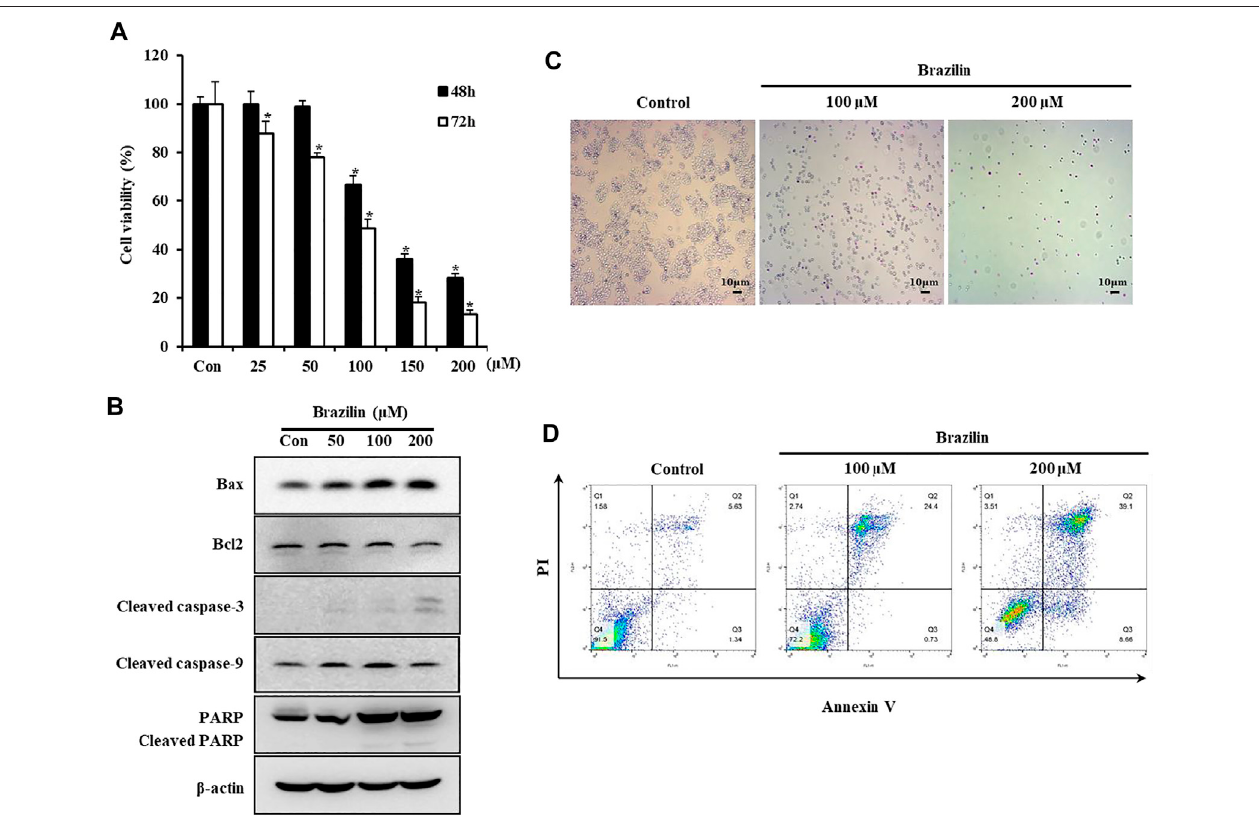
FIGURE 1 | The effects of brazilin on cell viability in colorectal cancer SW480 cells. (A) SW480 cells were treated with different dosages of brazilin for 48 h or 72 h. CellviabilitiesweremeasuredbyMTTassay.Dataareshownasmean±SDofthreeindependentexperiments.The p -valuesdeterminedusingStudent ’ st-testwere* p < 0.05 compared with controls. (B) SW480 cells were treated with different concentrations of brazilin for 72 h. Whole cell lysates were prepared, and apoptosis was assessed using Western blot analysis with anti-Bax, anti-Bcl2, anti-cleaved caspase-3, anti-cleaved caspase-9, and anti-PARP/cleaved PARP antibodies. After treatment with brazilin for 72 h, cells were analyzed using APOPercentage Apoptosis Assay kit (C) and fl ow cytometry with annexin V and PI staining (D) . The experiments were repeated for at least of three times.